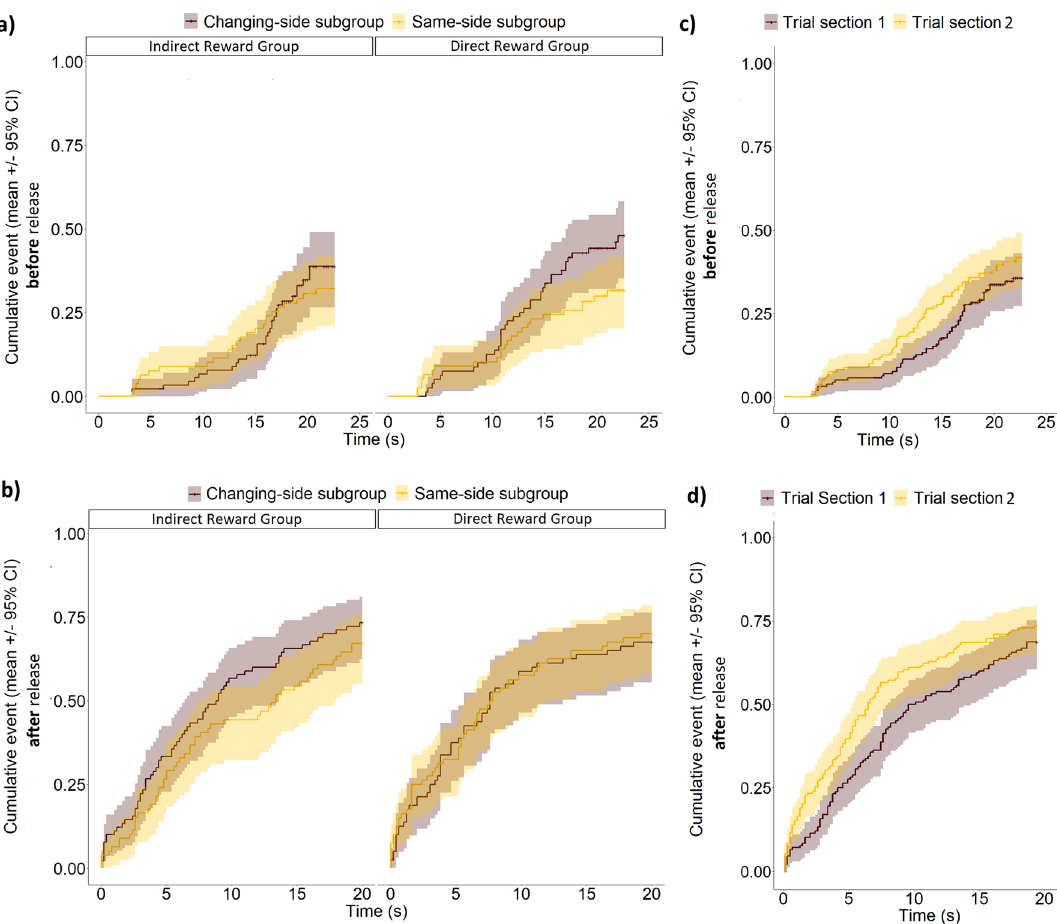
Figure 1. Latency to gaze at the UMO in the Familiarization phase. Reward group and Location subgroup (and their interaction) had no effect on the latency ( a ) before or ( b ) after release. Meanwhile, dogs gazed at the UMO sooner ( c ) before and ( d ) after release in the second (Trial section "Results") compared to the first (Trial section "Introduction") half of the Familiarization